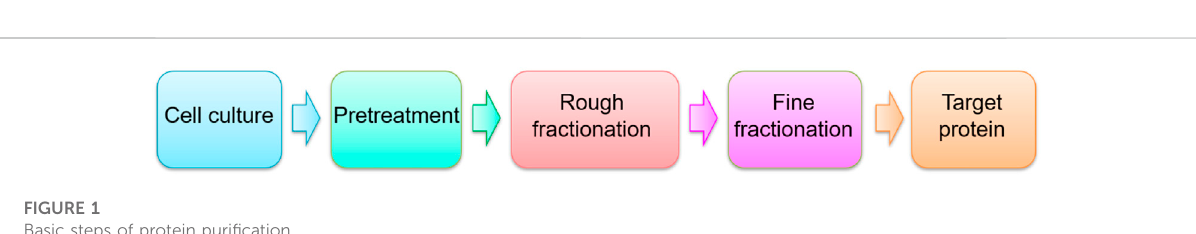
FIGURE 1 Basic steps of protein puri fi